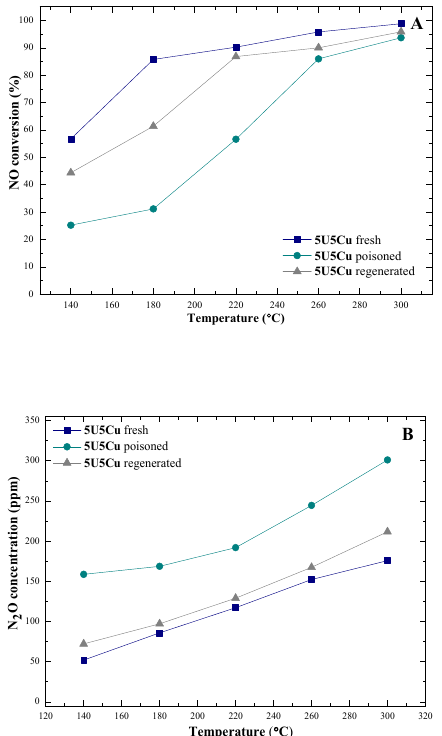
Figure 8. Results of catalytic tests carried out over fresh, poisoned, and regenerated 5U5Cu: ( A ) NO conversion; ( B ) N 2 O concentration.